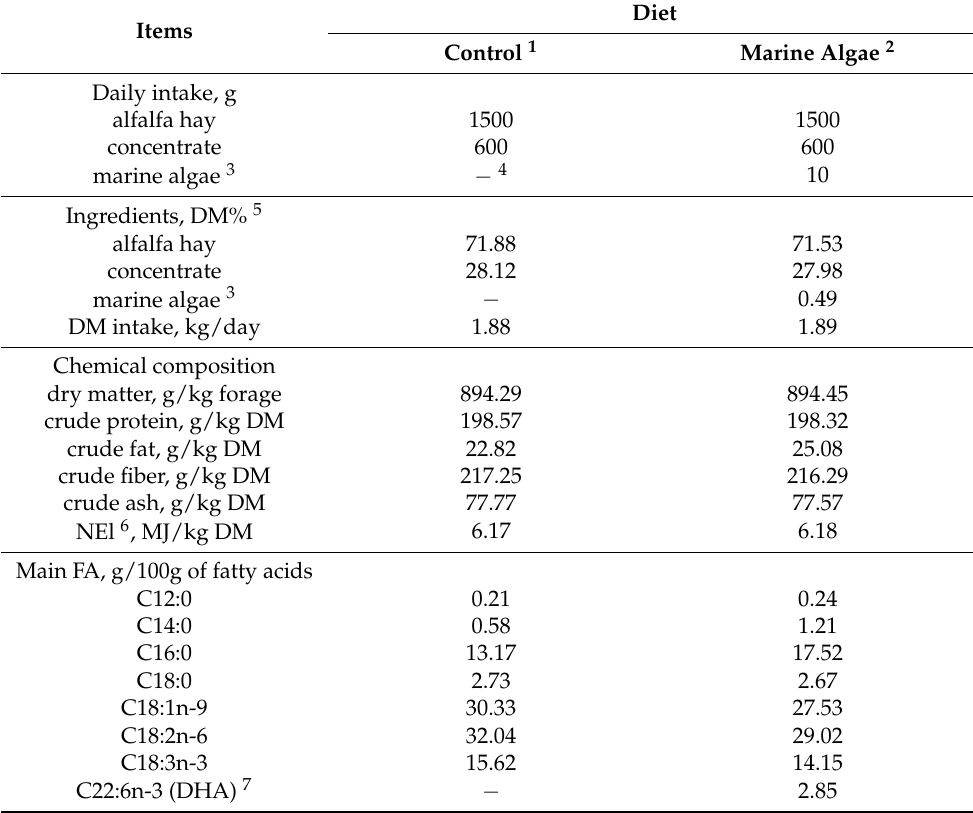
Table 1. Chemical composition and fatty acid (FA) profile of fed